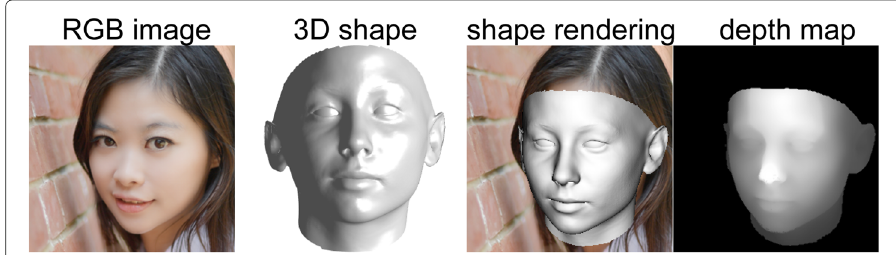
Fig. 6 Depth map by 3D reconstruction. An example of reconstructed depth map from a facial image by 3D reconstruction